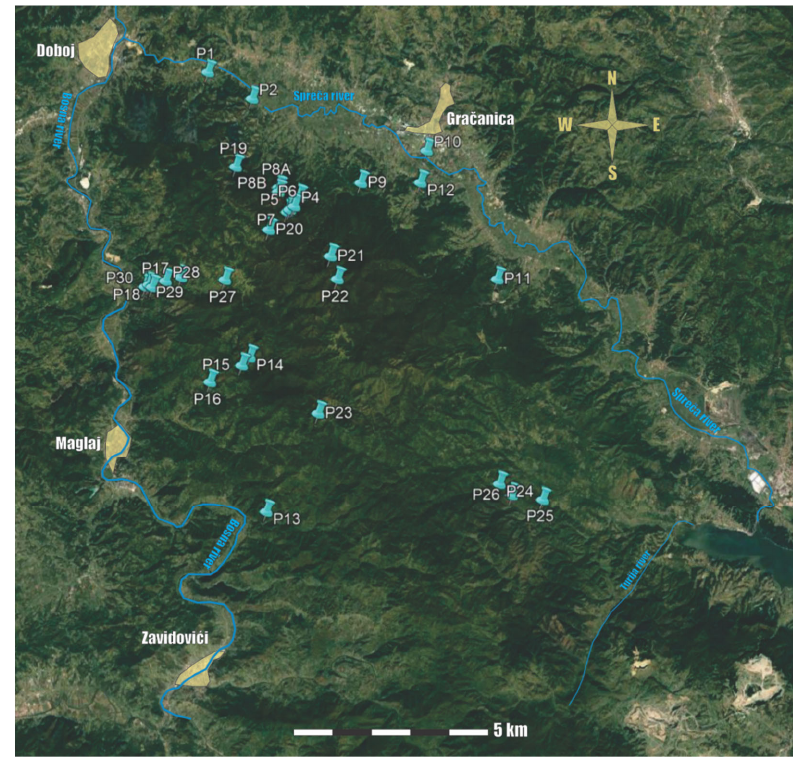
Figure 3. Sample location in the Ozren ophiolitic complex